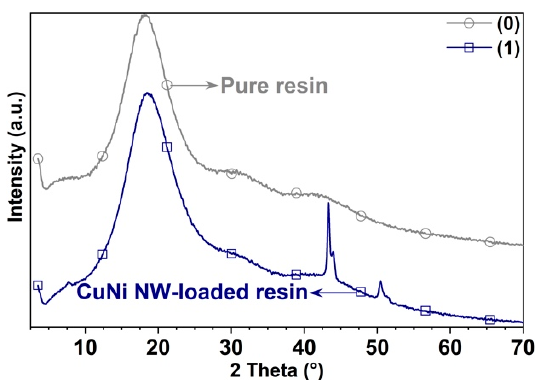
Figure 10. XRD patterns acquired on the substrates printed with (0) pure resin and (1) CuNi NW-loaded resin.